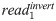
Identification of inversions.(a) Two breakpoints from the same inversion are broken into two clusters C1 and C2 owing to the intersection strategy; (b) The longer inverted region has been observed on the original chromosome; therefore, the final inverted region read1invert of r1 is ranged from (peright1+l) to (peleft1+μ) on reference.